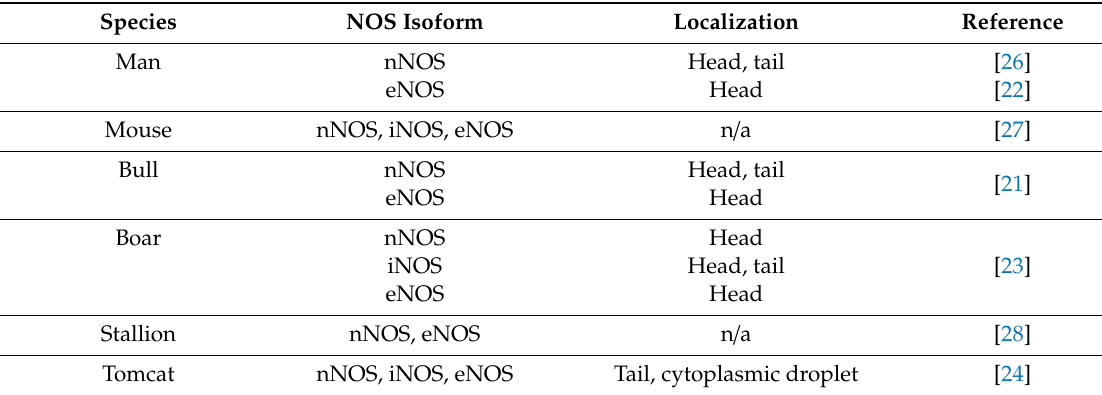
Table 1. The presence and localization of nitric oxide synthases (NOSs) in sperm of di ff erent species.